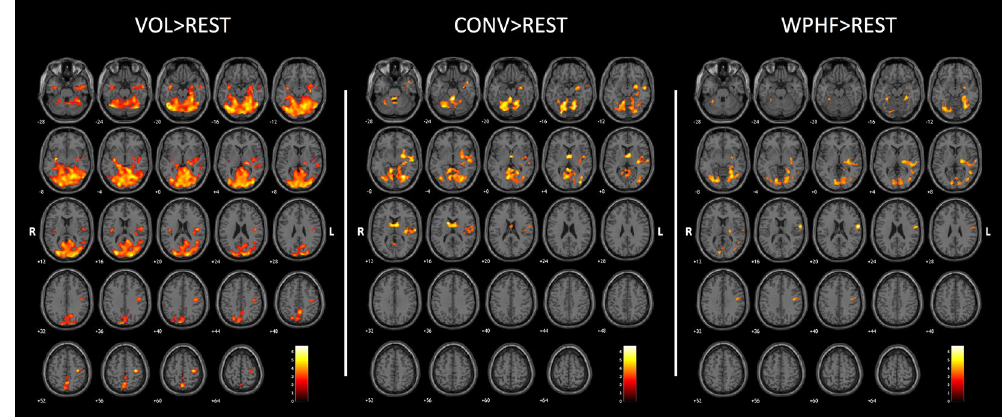
Figure 3. Group activation maps ( p < 0.005; k = 20; FDR corrected at cluster level p < 0.05) during VOL, CONV and WPHF protocols compared to rest, when considering the respective mean force as a regressor . Statistical maps were coregistered with the SPM-MNI single subject T 1 images. The color scale represents the T values. R: right hemisphere; L: left hemisphere.